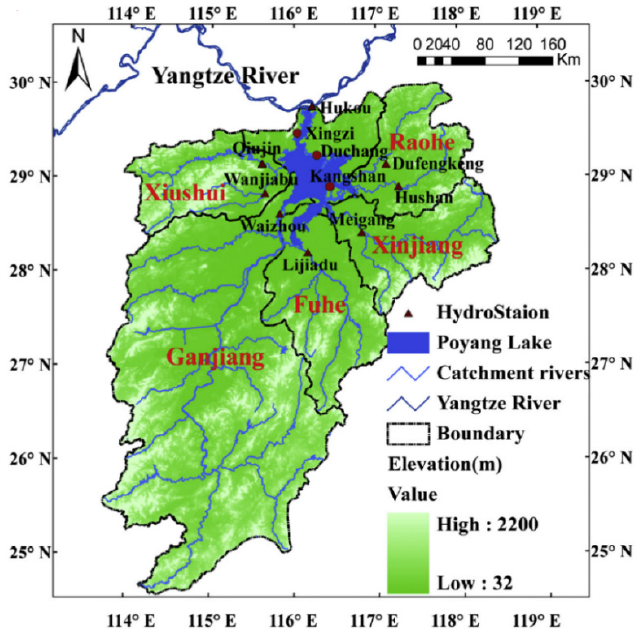
Figure 7. The Xingzi station and its location in the Poyang Lake and Yangtze River.